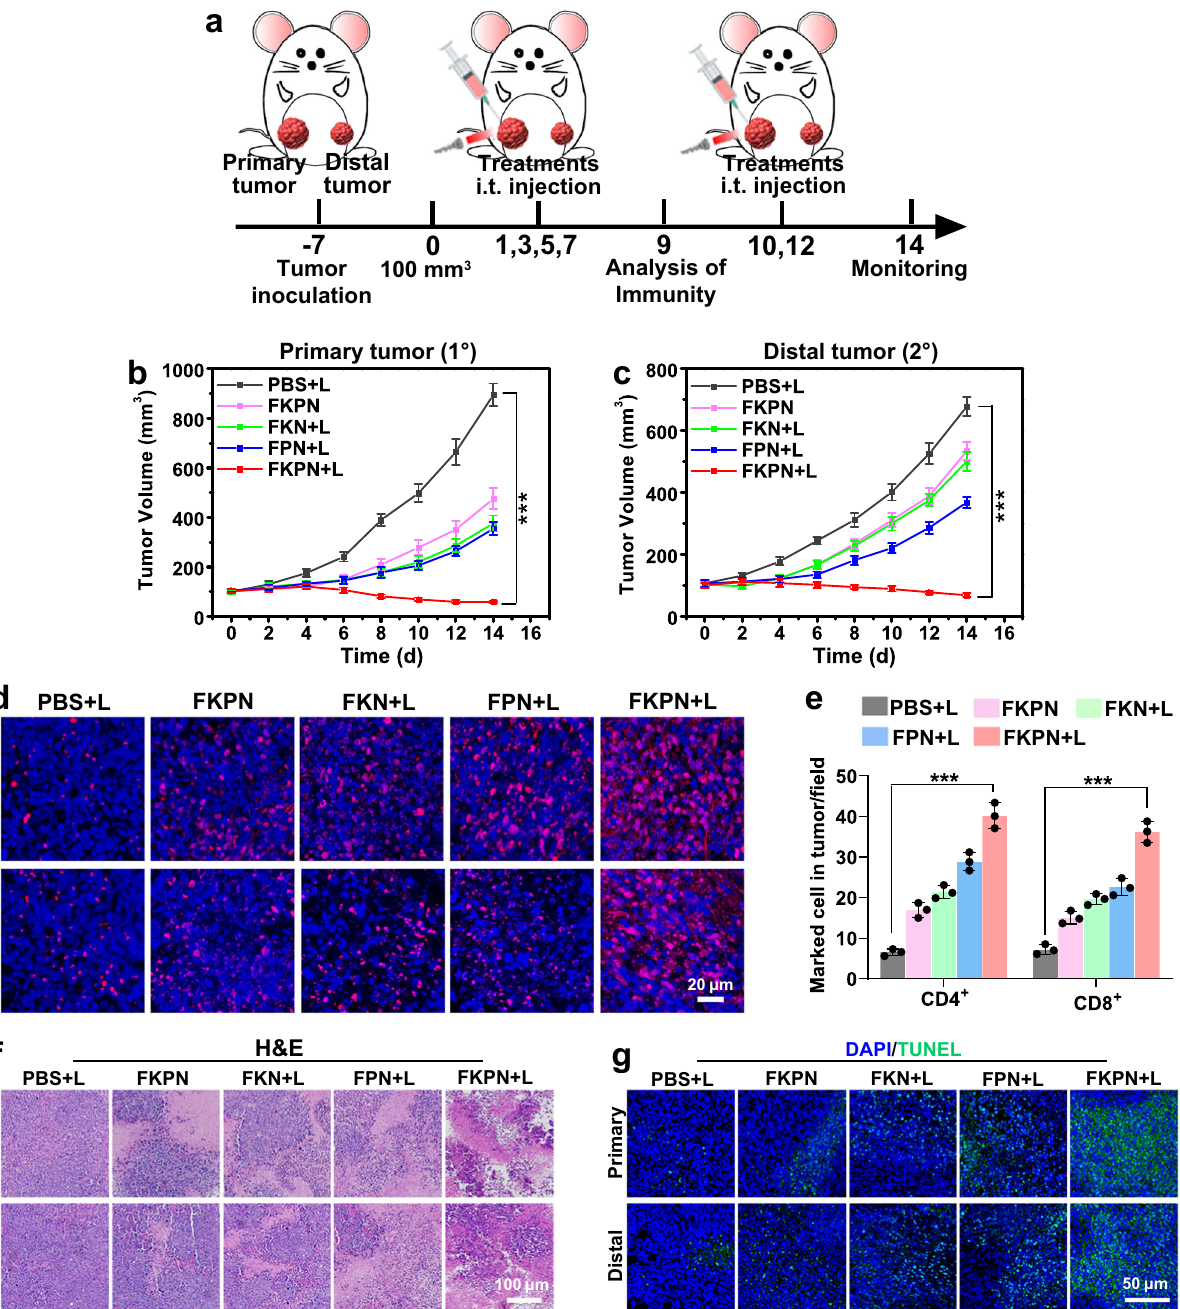
Fig. 6 | FKPN combined with laser irradiation induces systemic immune response-mediated abscopal effect. a Schematic illustration of treatment sche- dule using bilateral 4T1 breast cancer BALB/c mouse model. b Primary and c distal tumor growth curves of mice after various treatments. Data were presented as mean±SD ( n =6 mice). P values: 7.25826E-13 for primary tumor volume of mice in FKPN+LgroupvsinPBS+Lgrouponday14;4.3309E-13fordistanttumorvolume of mice in FKPN+L group vs in PBS+L group on day 14. d Immuno fl uorescence imagesofdistaltumortissuesstainedforCD4 + andCD8 + onday9. e Quanti fi cation